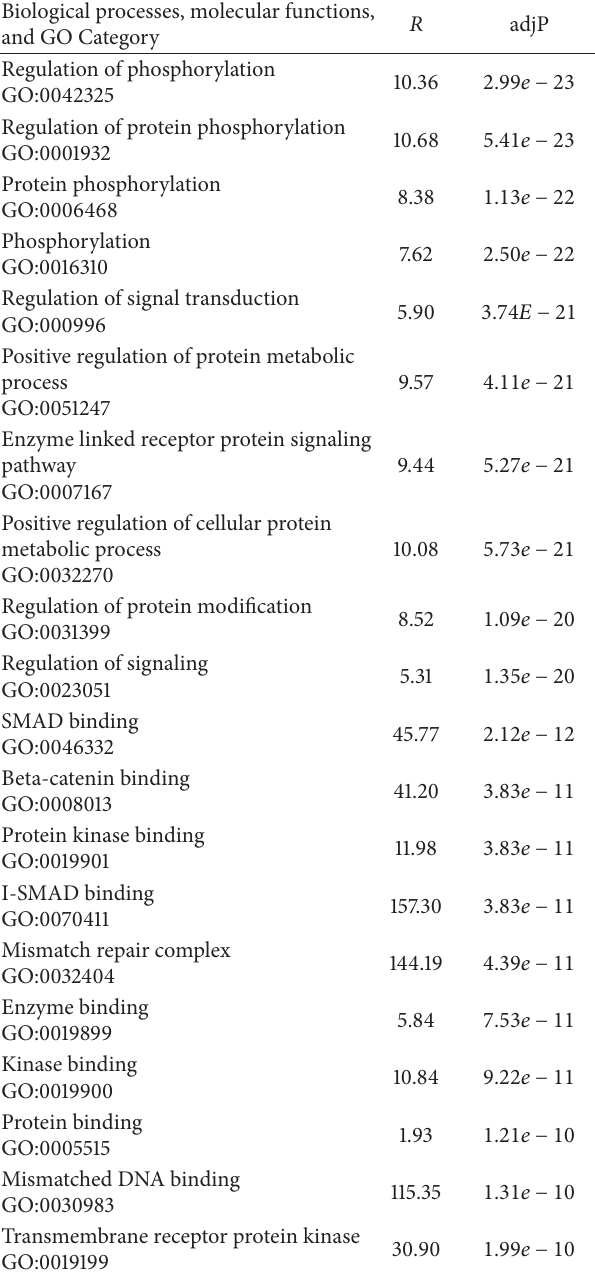
Table 3: Molecular functions and biological processes that the selected genes play a role in, along with their GO categories. Biological processes, molecular functions,